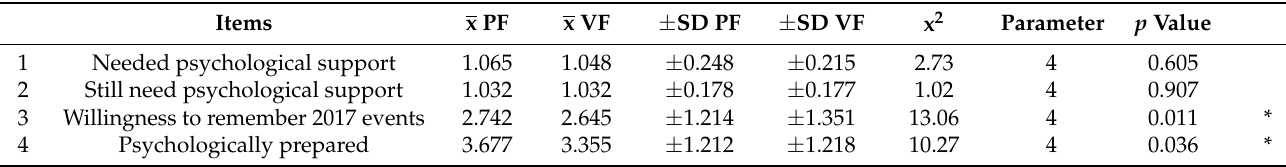
Table 10. Psychological support, PF vs. VF ( n =